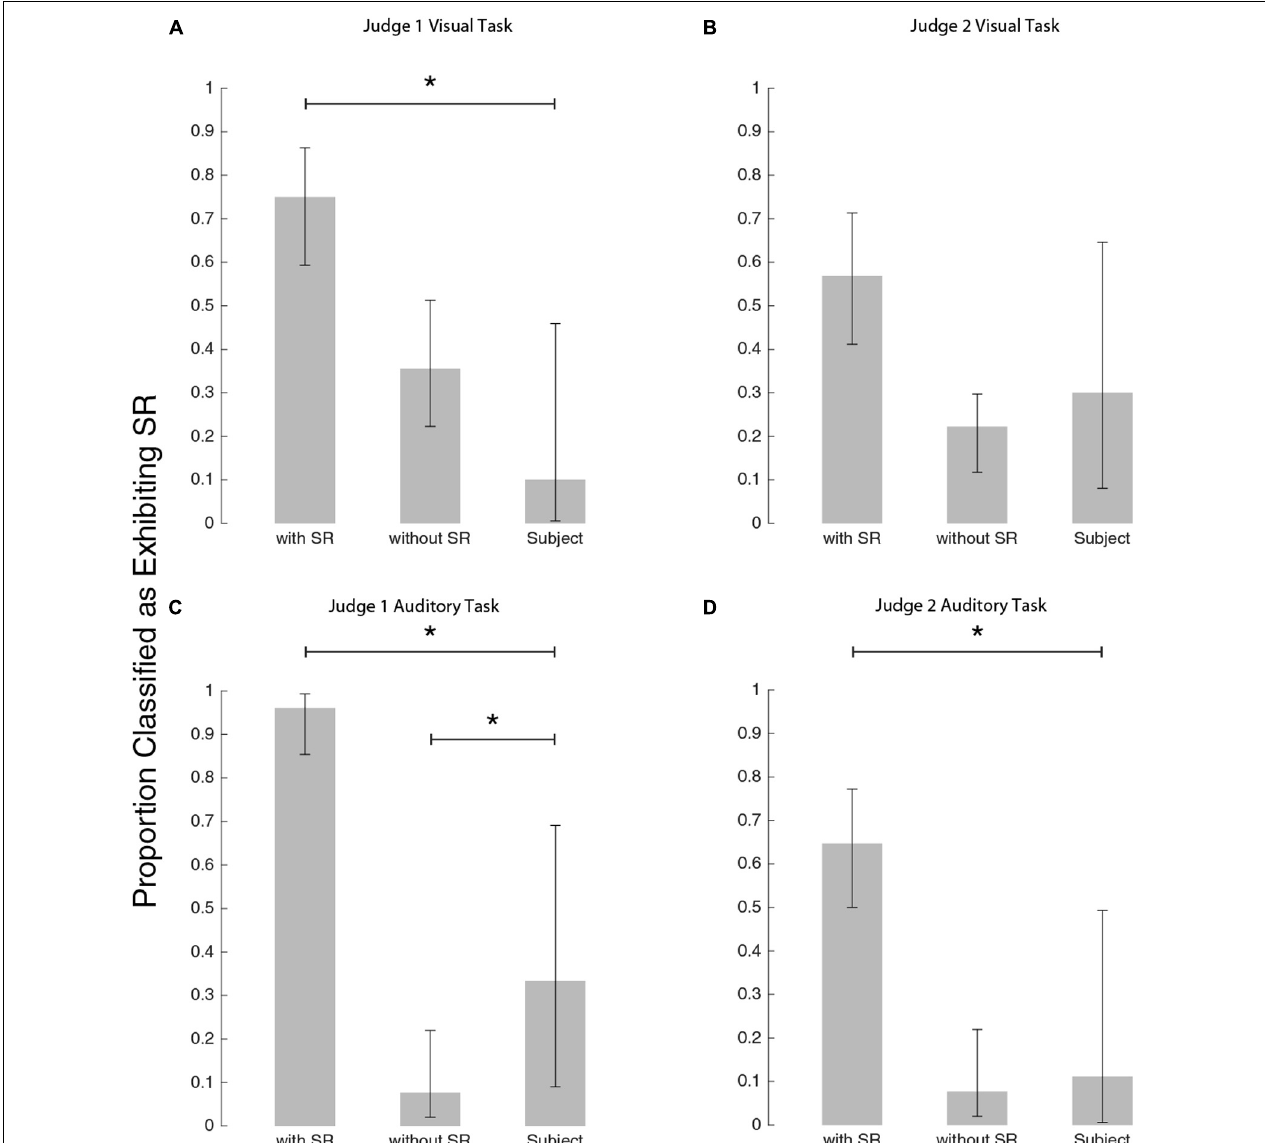
FIGURE 6 | Bar plots to show how the judges classified each group. (A) Judge #1 on visual task, (B) Judge #2 on visual task, (C) Judge #1 on auditory task, and panel (D) Judge #2 on auditory task. Stars indicate a significant difference between classification proportions by Chi-square tests (see text for